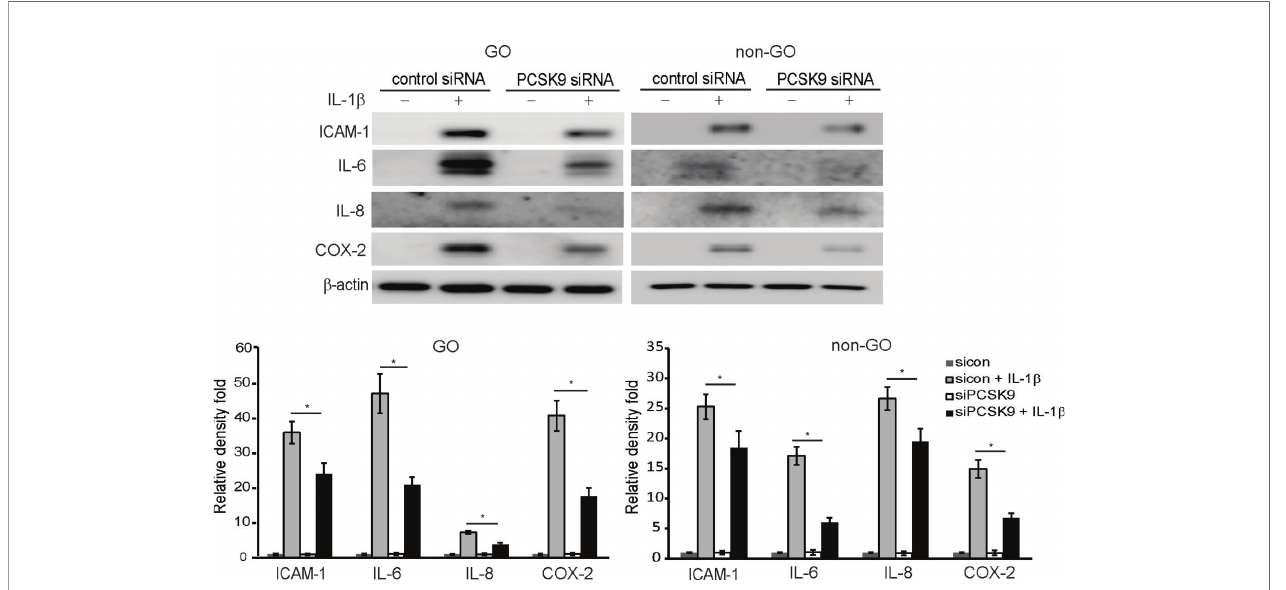
FIGURE 3 | Effect of silencing proprotein convertase subtilisin/kexin type 9 (PCSK9) on the expression of pro-in fl ammatory cytokines protein. Con fl uent fi broblasts obtained from Graves ’ orbitopathy (GO) patients (n=3) were treated with either control siRNA or PCSK9 siRNA (50 nM, 24 h). Then, they were challenged with 10 ng/ml of interleukin-1 b (IL-1 b ) and compared to non-IL-1 b -treated counterparts. Western blot analyses were conducted to compare the levels of pro-in fl ammatory cytokines, intercellular adhesion molecule 1 (ICAM-1), IL-6, IL-8, and cyclooxygenase-2 (COX-2). The same experiment was repeated with fi broblasts obtained from non-GO subjects (n=3). Representative gel images are shown. The mean density ratio ± SD from fi broblasts were normalized to the level of b -actin in the same sample (* p < 0.05 between sicon + IL-1 b and siPCSK9 + IL-1 b ; sicon, control siRNA; siPCSK9, PCSK9